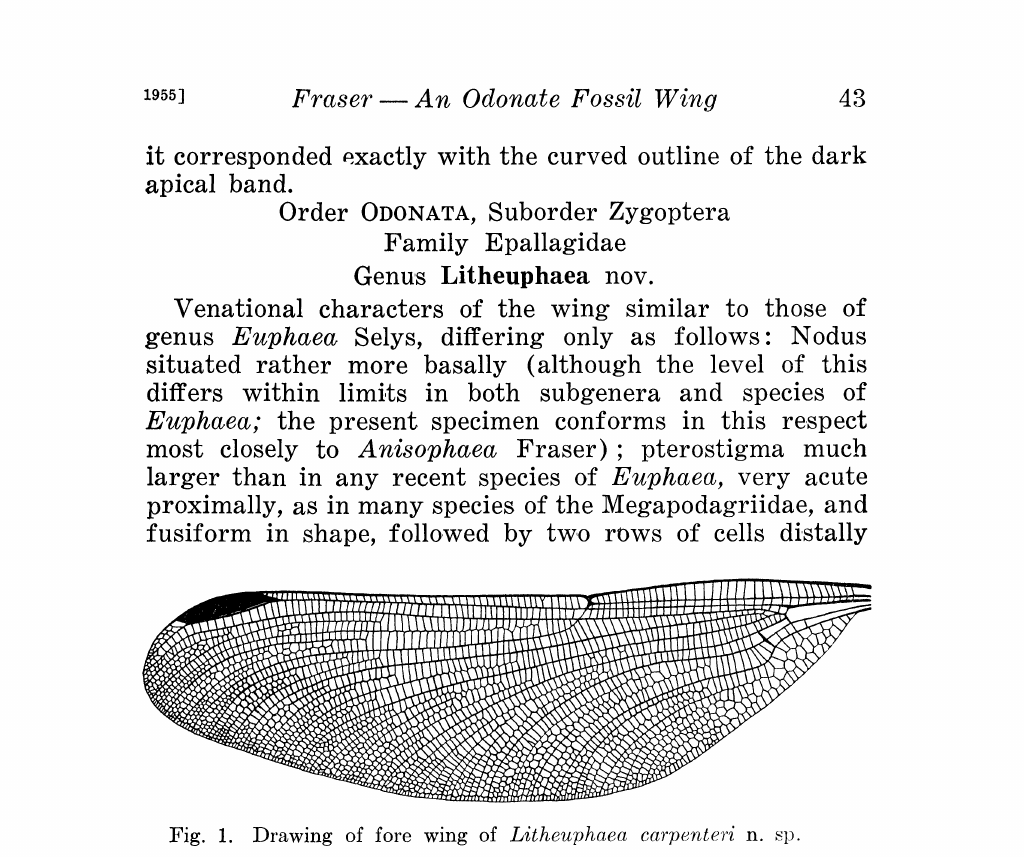
Fig. 1. Drawing of fore wing of Litheuphaea carpenteri n.